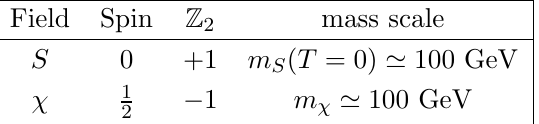
Table 2 . The dark sector of the vev-induced freeze-in